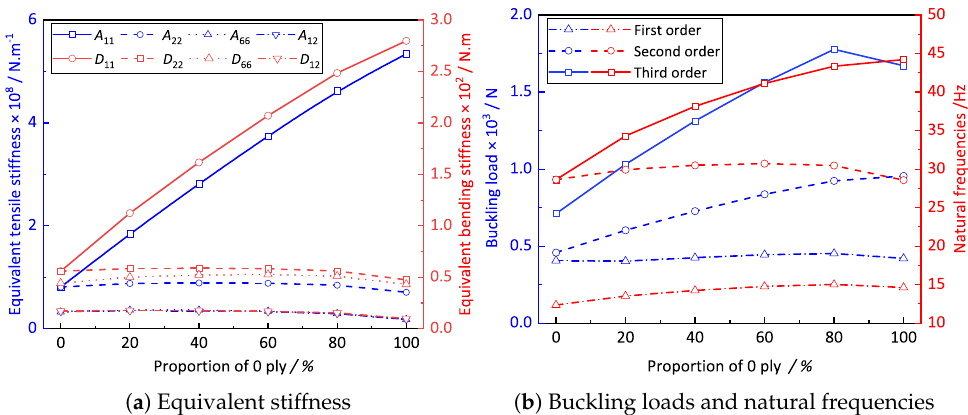
Figure 14. The influence of proportion of 0 ◦ ply on the effective performance of CCCP.